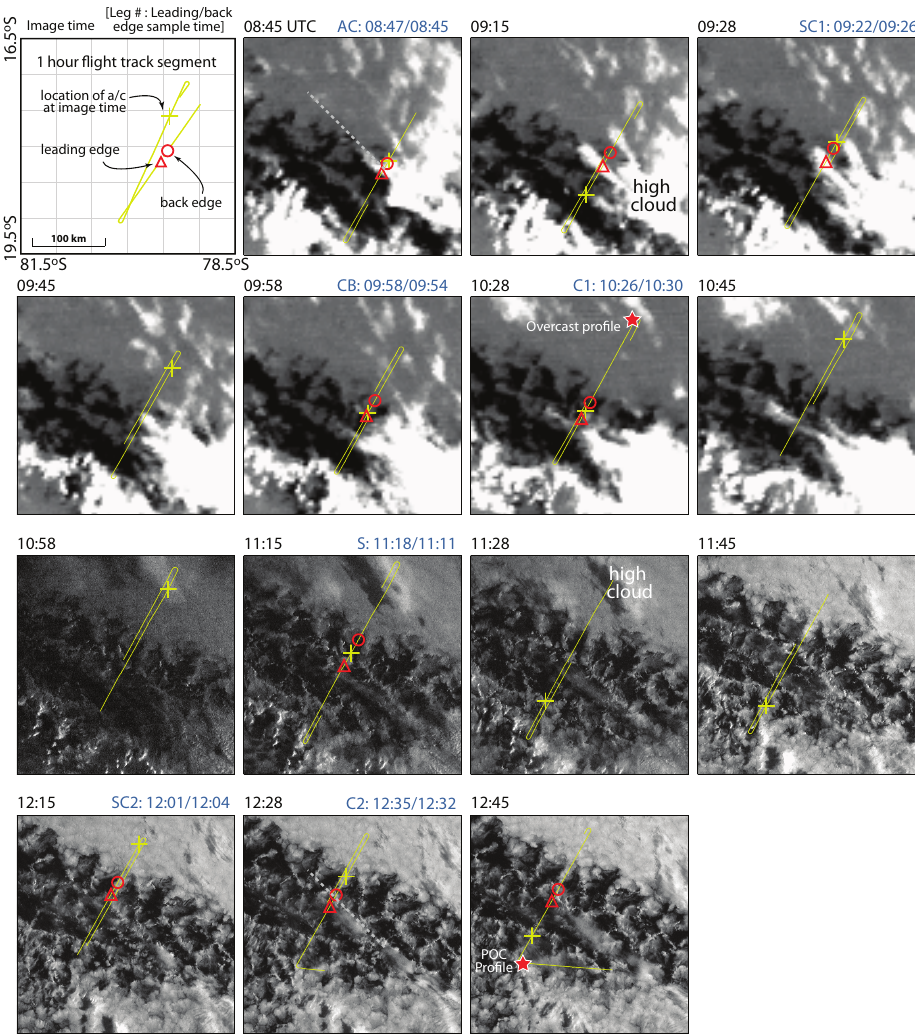
Fig. 4. GOES IR imagery (upper two rows) and visible imagery (lower two rows) between 08:45 UTC and 12:45 UTC 28 October with near-coincident hour-long sections (yellow) of the C-130 flight track during RF06, centered on the image time overlaid. The yellow cross shows the location of the aircraft at the time of the image, with the image time shown at top left of the panels. The aircraft track before and after the image time is advected using the mean low level flow determined from the aircraft data to account for cloud motion. The red triangle and circle show locations of the leading and back edges of the transition region, respectively (see text), and are plotted on the run most closely coincident with the satellite data (run given in blue text at top right of panel, with times showing when the leading/back edge was crossed. The red stars represent the approximate location of the aircraft during the two representative profiles used to characterize the vertical structure in the POC and overcast regions. The gray dashed line in the 08:45 and 12:28 panels shows the track of the leading edge sampled at 08:45 if it were advected with the mean MBL winds for the approximately 3.75 hours between these two times. 40